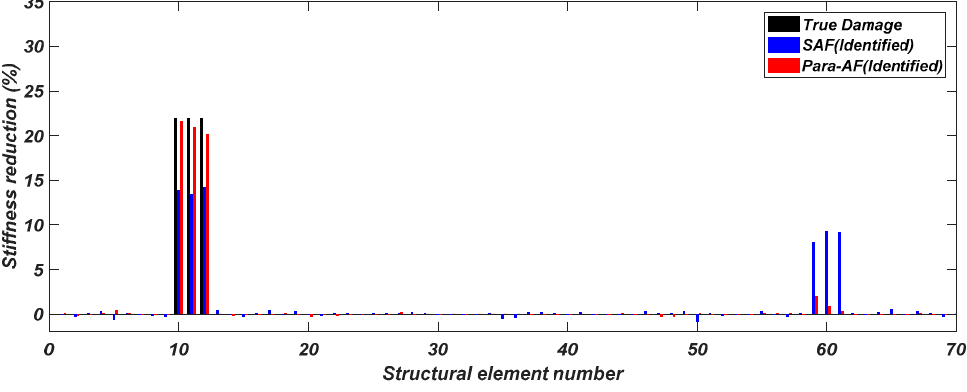
Figure 6. An example of multiple damage identification of SAF and the proposed approach.